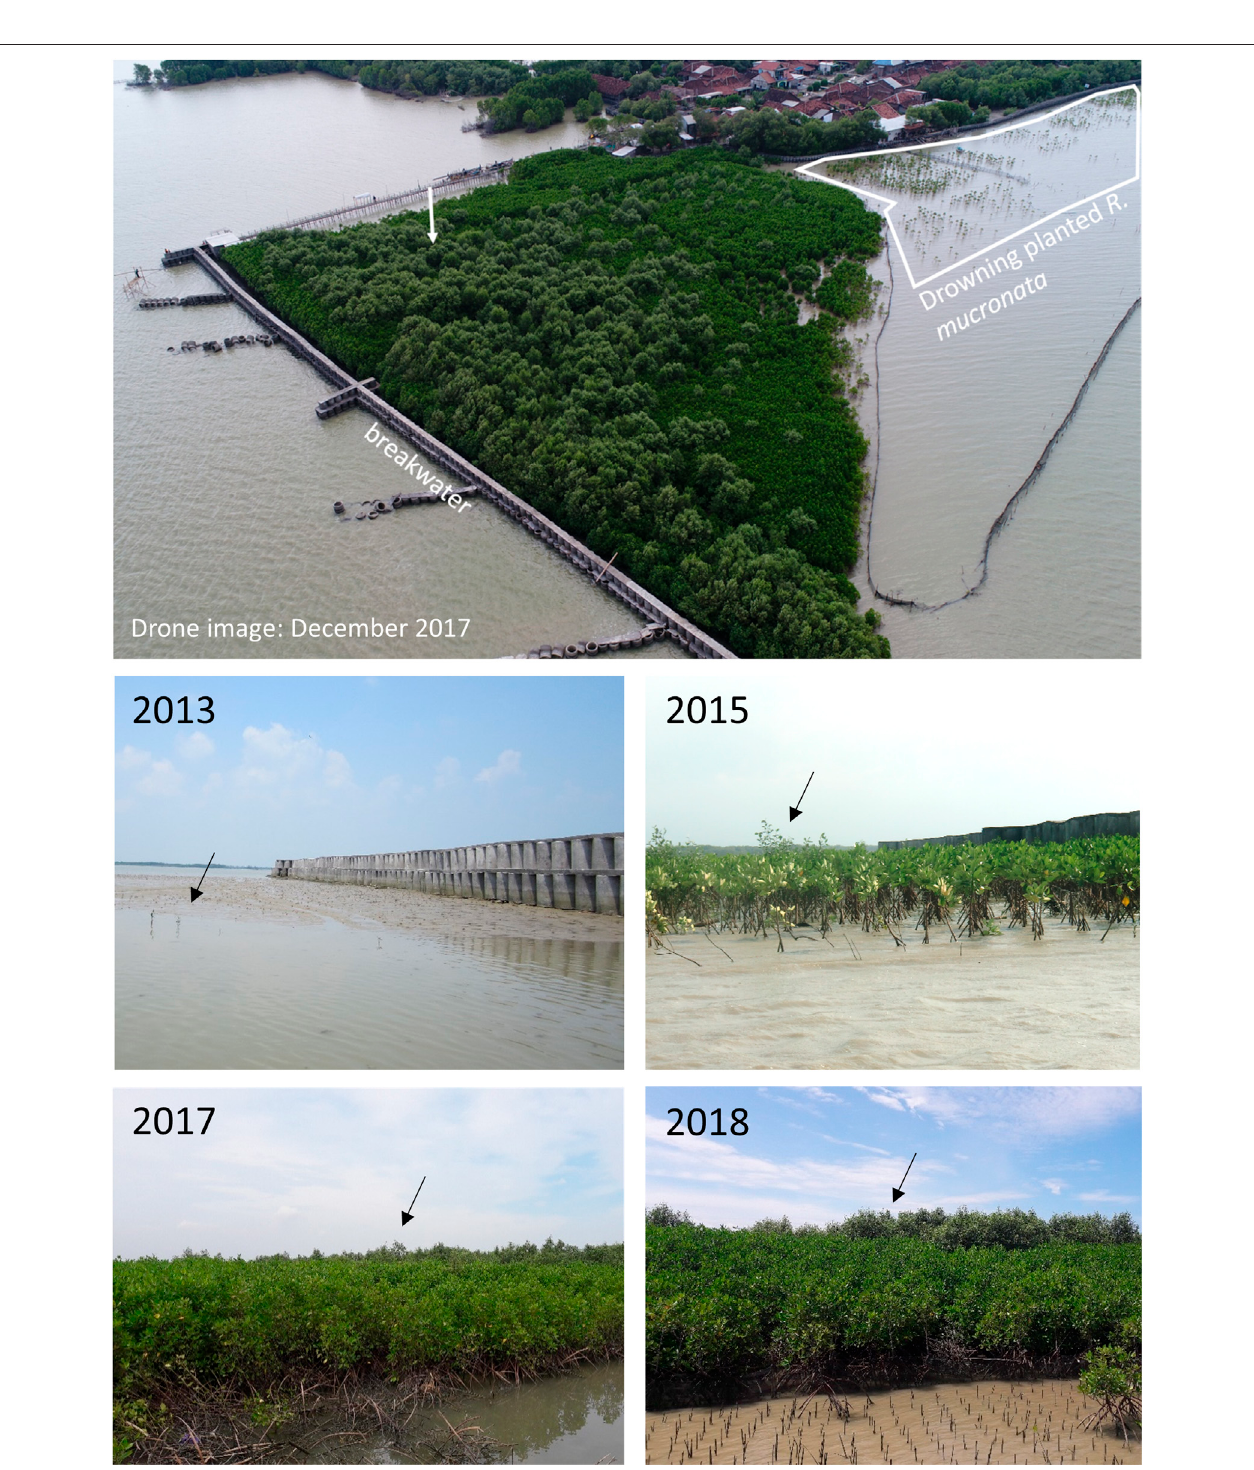
FIGURE9| Top:Bird ’ s-eyeviewofthebreakwaterseawardofWonerejo, Demakin2017(droneimage courtesyofCoREM-UNDIP). Thewhitearrowindicatesthe direction of the picture time series. The time series show the development of a mud fl at after construction of the breakwater in 2012, followed by natural colonization in 2013 and subsequent planting of R.mucronata in2014. Note the relative height difference inall pictures ofthe naturally colonized A.alba trees (black arrows) versusthe surrounding planted R. mucronata trees (2015 – 2018).